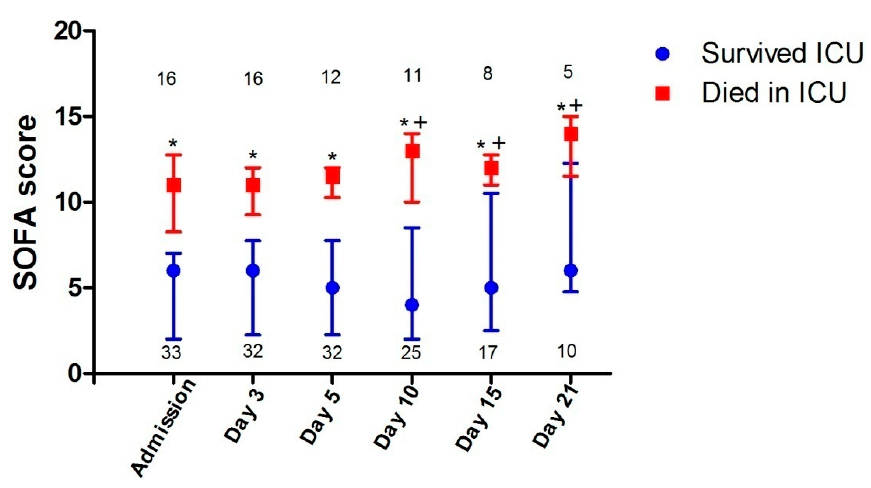
Figure 2. Serial SOFA scores of patients admitted to the ICU and either survived or died in ICU. Days represent ICU days. Values are medians and error bars are interquartile ranges. Numbers represent the number ( n ) of patients on each day. Asterisks (*) denote significant di ff erences between those who died and those who survived on the same ICU day ( p < 0.01; Mann–Whitney U test), whereas crosses ( + ) denote significant di ff erences in patients who died between SOFA scores on days 10, 15 and 21 and SOFA scores on admission, day 3 or day 5 ( p < 0.05; Wilcoxon matched-pair test). Abbreviations: SOFA = Sequential Organ Failure Assessment, ICU = intensive care unit.